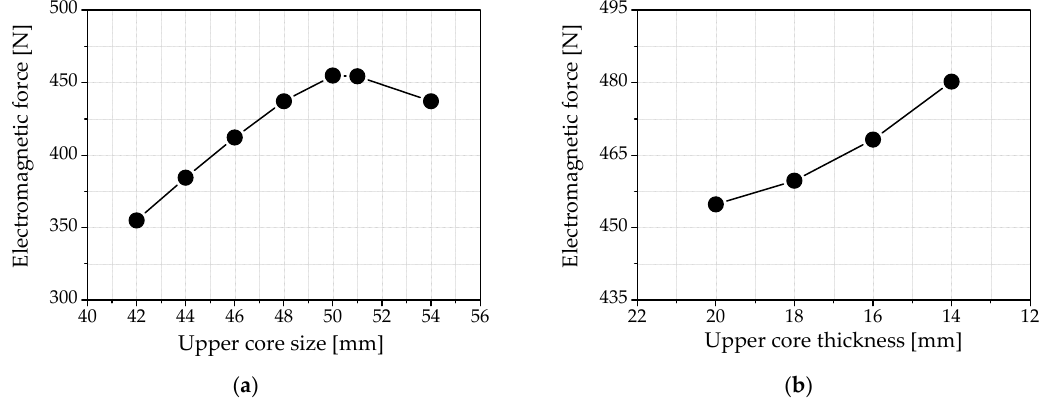
Figure 17. H-EMM performance results according to ( a ) upper core width and length; ( b ) upper core thickness.